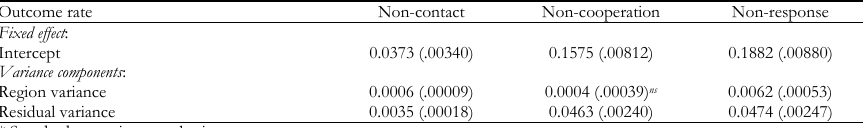
Null model for non-contact, non-cooperation and non-response rates: solutions for fixed and random effects – 2004 Outcome rate Non-contact